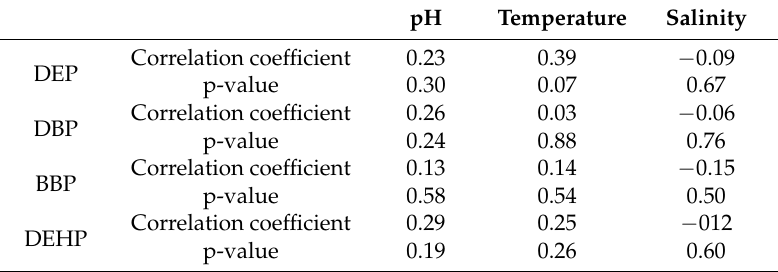
Table 5. Multivariate analysis for PAEs with influencing